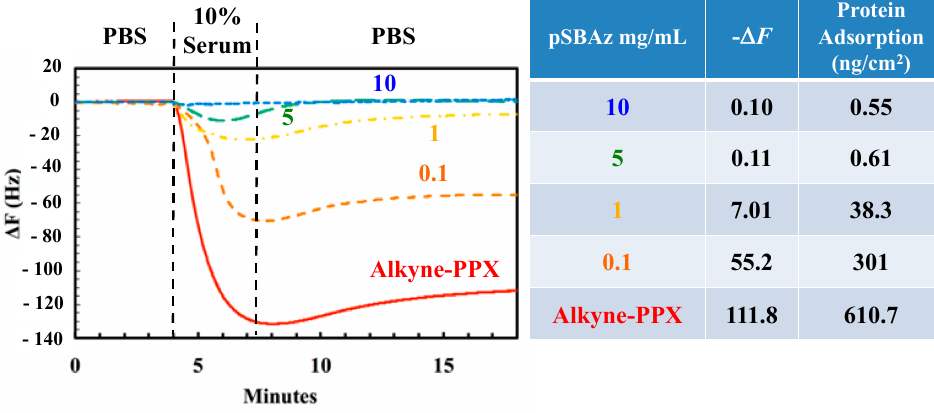
Figure 2. QCM analysis of protein adsorption from 10% fetal bovine serum to piezoelectric quartz